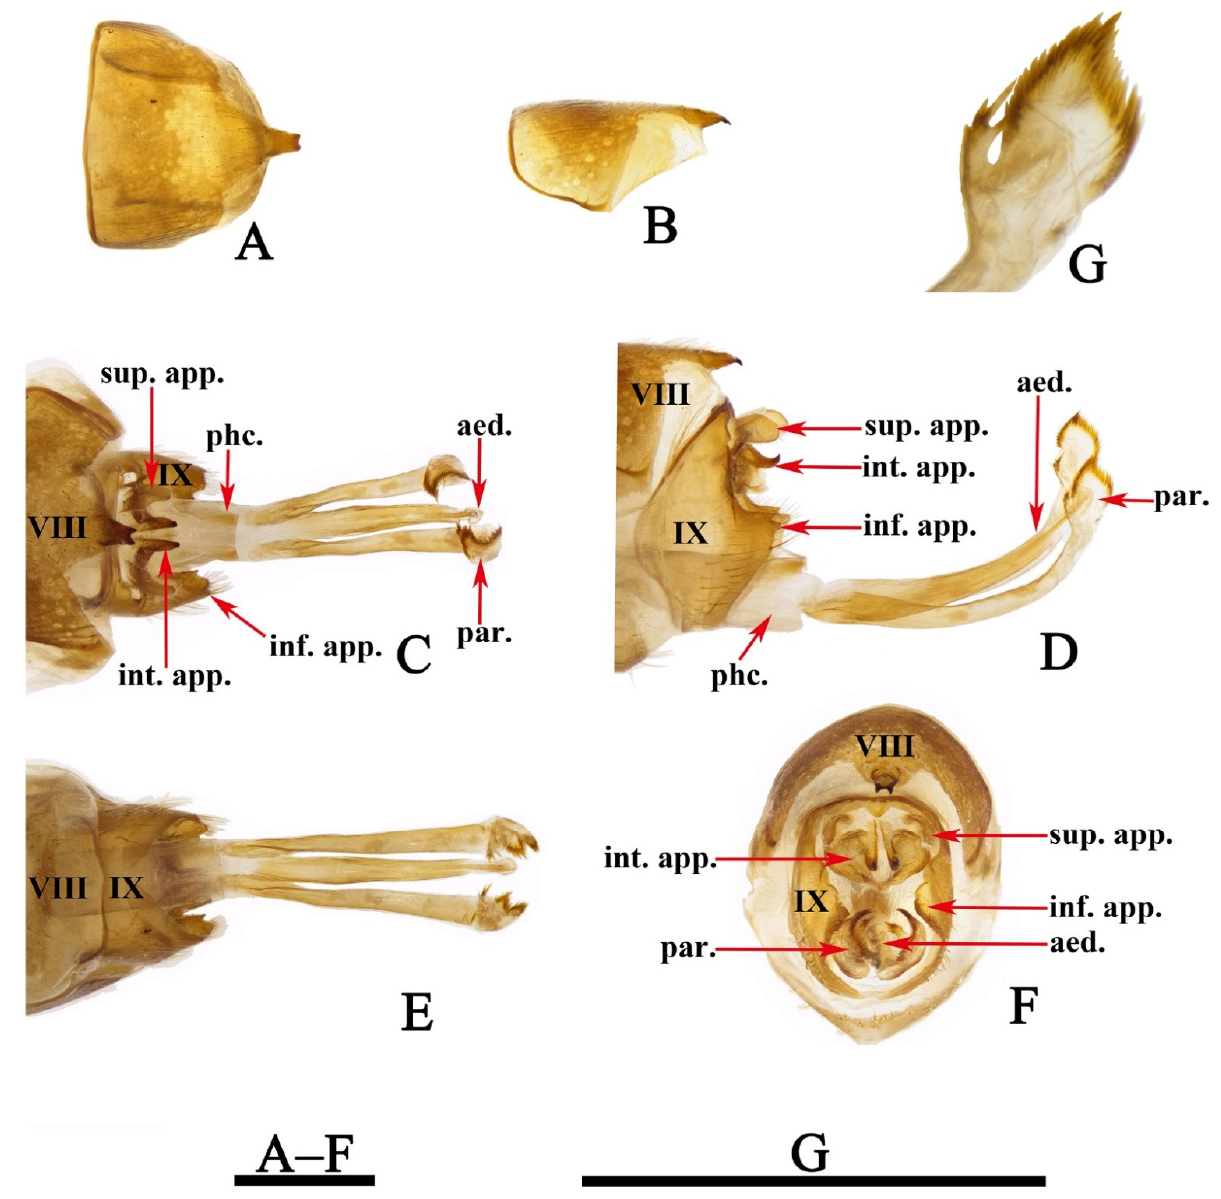
Figure 3. Limnephilus deqianensis n. sp. , male genitalia. ( A ) Segment VIII, dorsal; ( B ) segment VIII, left lateral; ( C ) dorsal; ( D ) left lateral; ( E ) ventral; ( F ) caudal; ( G ) left lateral paramere subapex and small lobe, left lateral. Abbreviations: sup. app. = superior appendages (paired); int. app. = intermediate appendages (paired); inf. app. = inferior appendages (paired); phc. = phallocrypt; aed. = aedeagus; par. = paramere (paired). Scale bars: 1 mm.